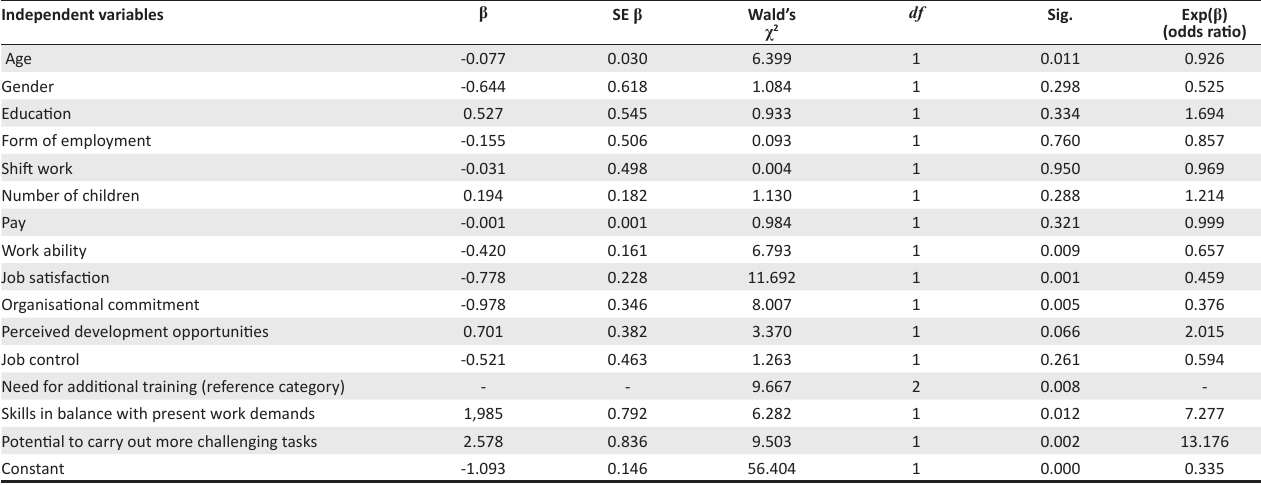
TABLE 4: Logistic regression analysis of the intention to leave the profession. Independent variables